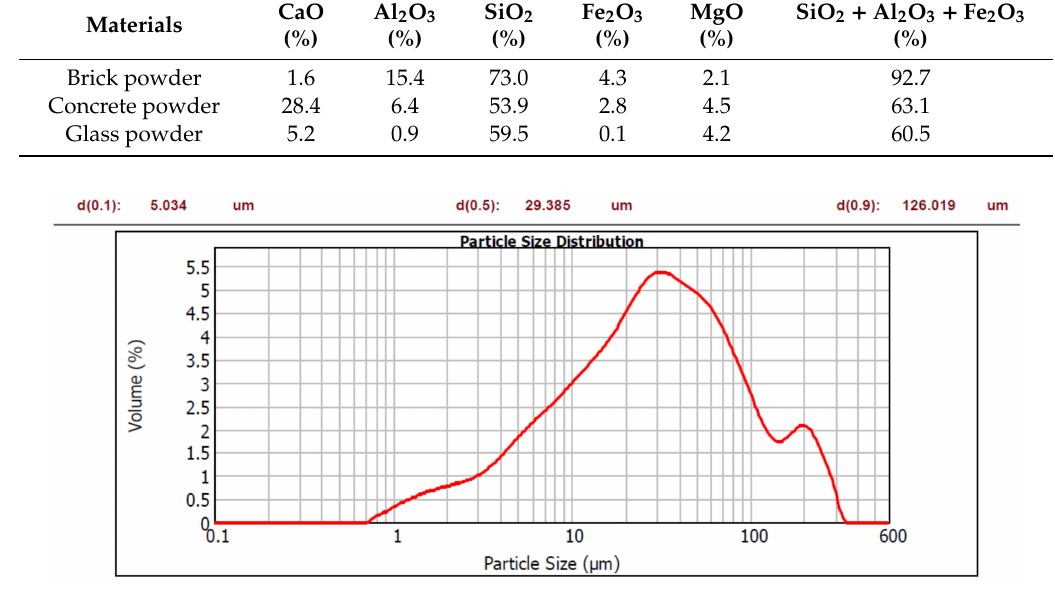
Figure 2. Particle size distribution of brick